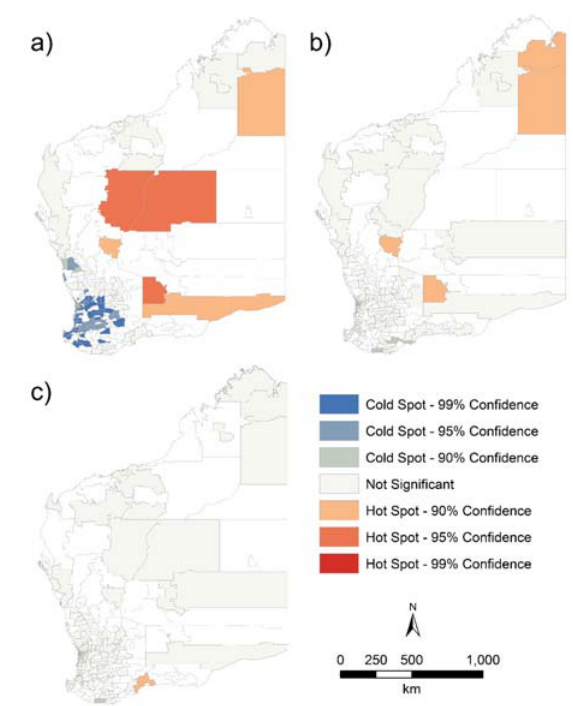
Figure 10. Hotspot analysis of relationship of PHC to PPH for State (a), ARIA-based regions (b) and Health Regions (c)